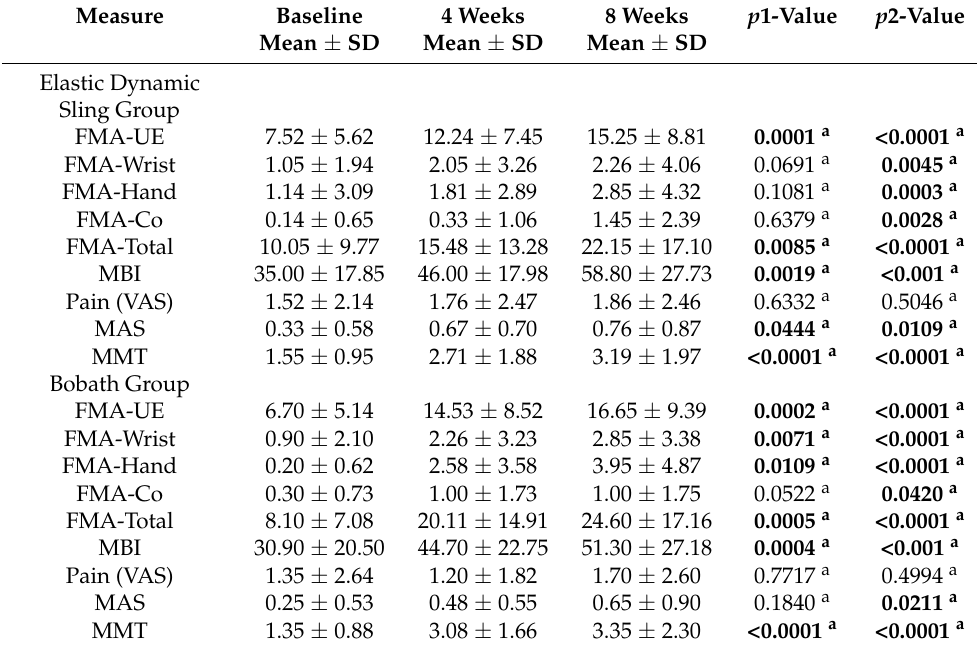
Table 5. Comparison of VAS, FMA-UE, MBI, MAS, and MMT within the groups at four and eight